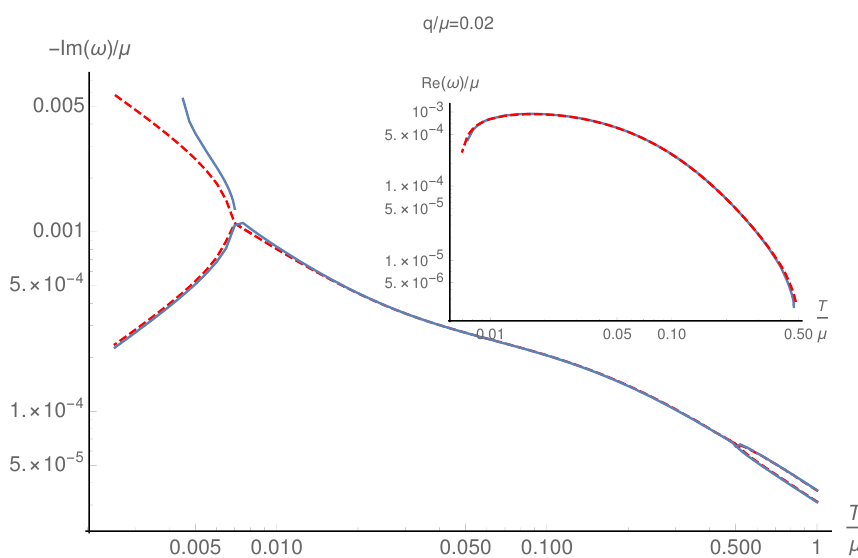
Figure 5 . Comparison of the exact location (numerics, solid blue) and hydrodynamic approxi- mation (6.1) (dashed, red) of the real (inset) and imaginary part of the transverse hydrodynamic QNM at q=(cid:22) = 0 : 02 vs T=(cid:22) . At intermediate temperatures, they follow very well the dispersion relation of shear sound waves predicted by WC hydrodynamics. At both very high and very low T , the modes collide and become purely imaginary and pseudo-di(cid:11)usive. Keeping T=(cid:22) (cid:12)xed, they modes acquire a nonzero real part as q is lowered, see (cid:12)gure